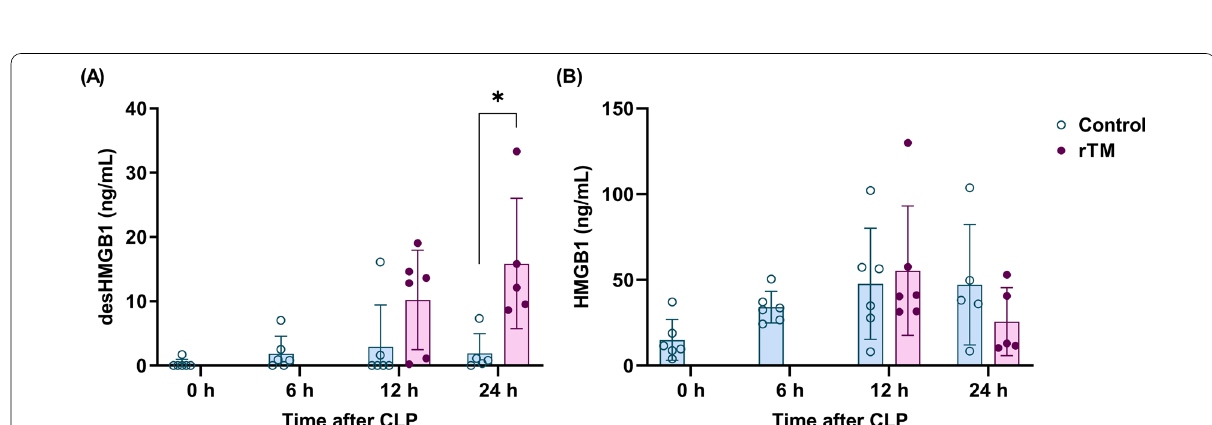
Fig. 4 Plasma levels of desHMGB1 in response to rTM treatment in CLP-induced septic mice. Male C57BL/6J mice were subjected to a severe model of CLP-induced sepsis. Mice were randomly divided into the following two groups: those treated with saline and those treated with rTM (5 mg/kg, intravenously) at 6 h after CLP. Plasma samples were collected at 0, 6, 12, and 24 h after CLP, and the plasma levels of desHMGB1 ( A ) and HMGB1 ( B ) were analyzed using ELISA. Six mice were allocated to each time point in each group; however, one mouse in each group became moribund before 24 h. These two mice were sacrificed before 24 h and excluded from further analyses. Data are shown as means significance was determined using the Holm–Šidák method. * P <